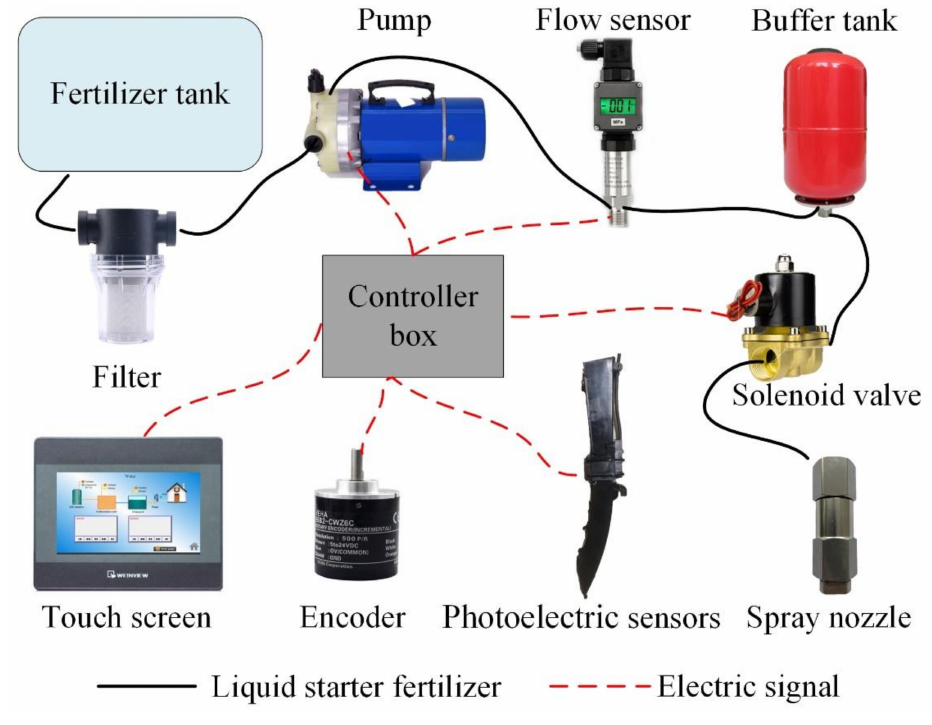
Figure 2. Components of the precise application system for a liquid starter fertilizer.